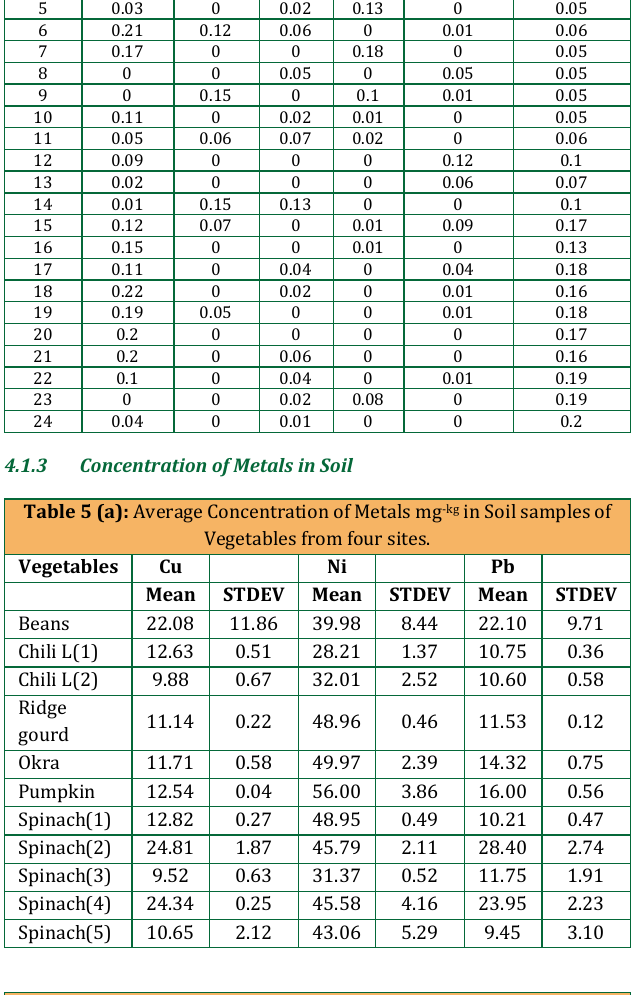
Table 5 (b): Average Concentration of Metals mg -kg in Soil samples of Vegetables from four sites.